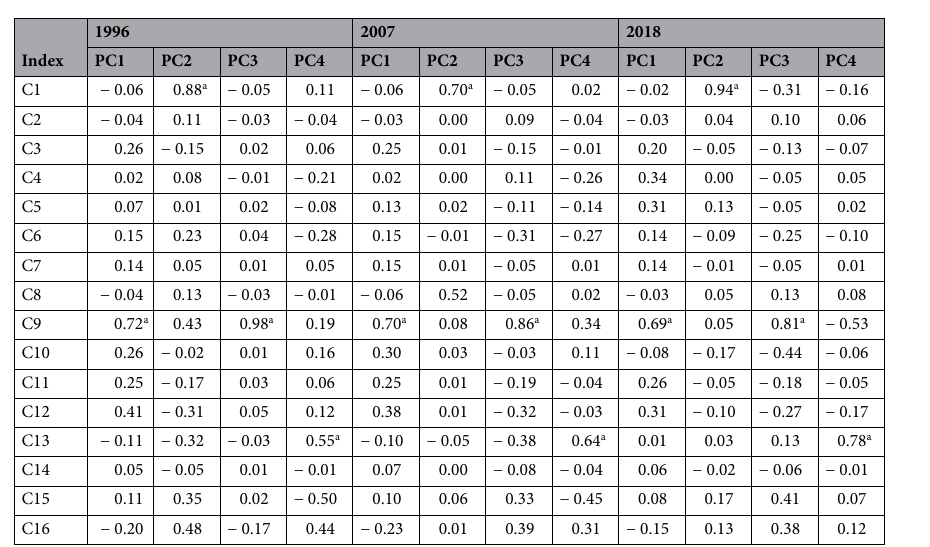
Table 6. Principal component loading and score. a Represents that the contribution of this ingredient is